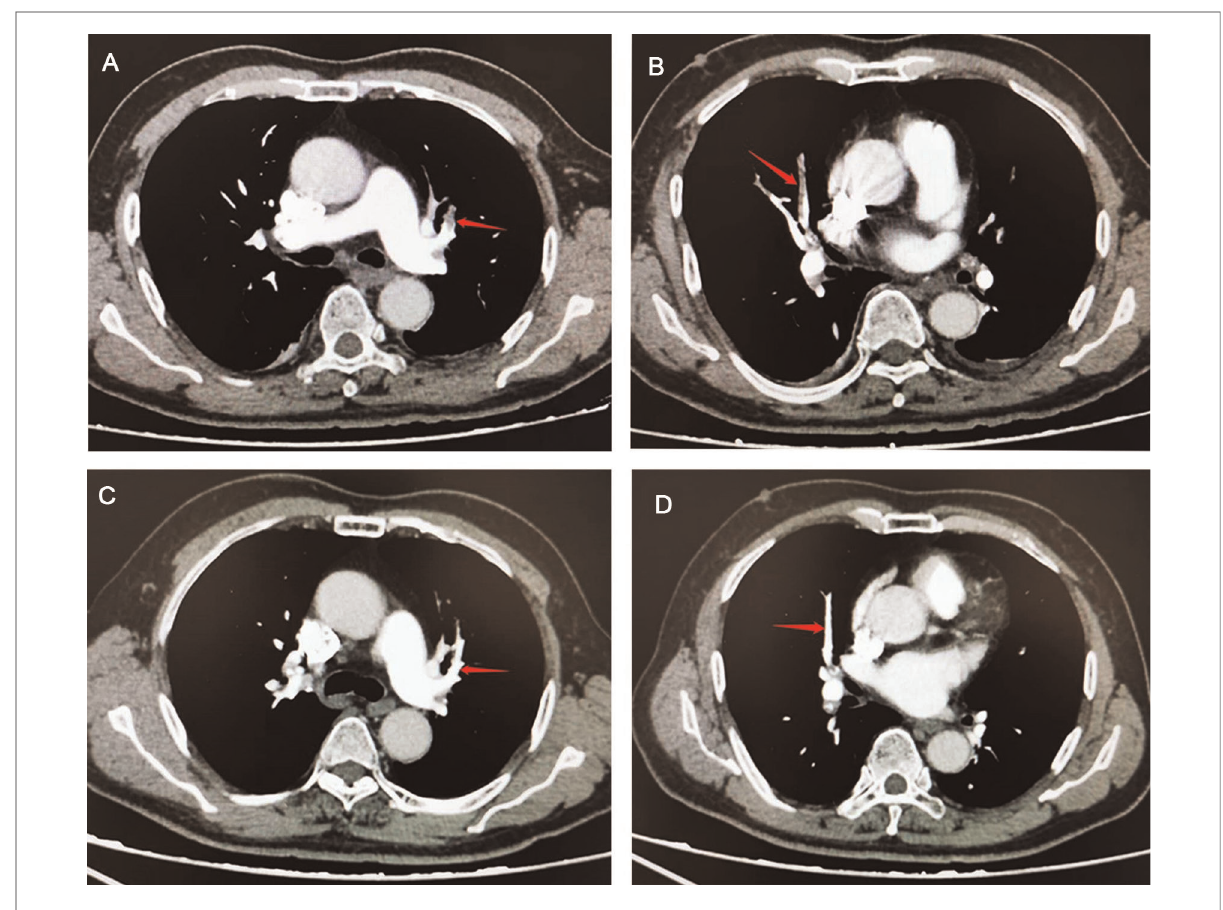
FIGURE 2 Comparison of computed tomographic pulmonary arteriography (CTPA) images before and after treatment in a pulmonary embolism (PE) patient. ( A , B ) CTPA shows fi lling defects in the left upper pulmonary artery and right upper pulmonary artery (red arrow). ( C , D ), CTPA shows that fi lling defects in the left upper pulmonary artery and right upper pulmonary artery have disappeared after administering anticoagulants for one month (red